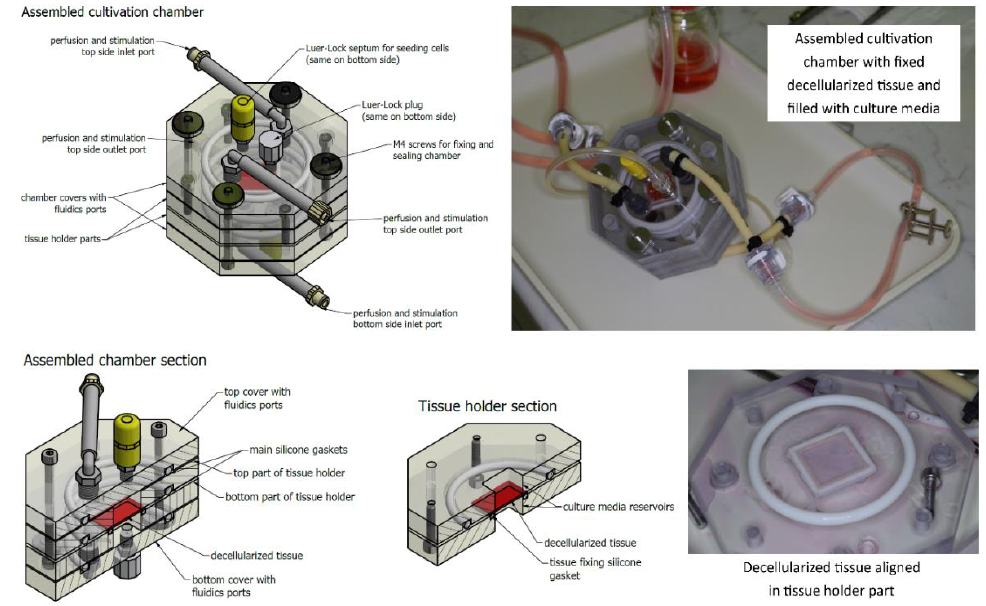
Figure 2. Overall schematic view of the cultivation chamber with sections of the main parts